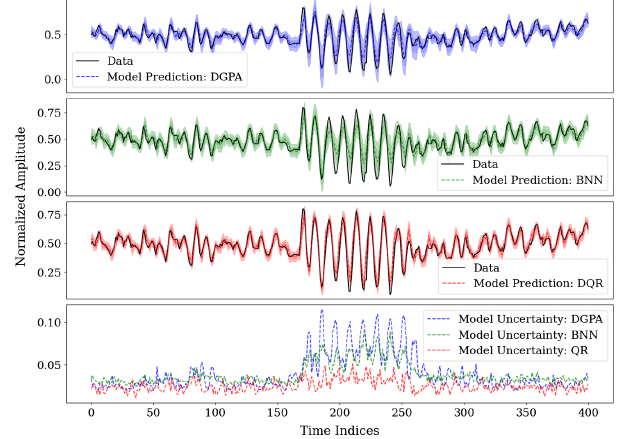
FIG. 5. Side-by-side comparison of the predictive performance as well as uncertainty quantification results for in-distribution and out-of-distribution samples for DGPA, BNN, and DQR, respec- tively. The middle region with the high frequency component on the time series represents OOD samples while the initial and tail- end regions represent in-distribution data samples. FIG. 6. Comparison of miscalibration between DGPA, BNN,